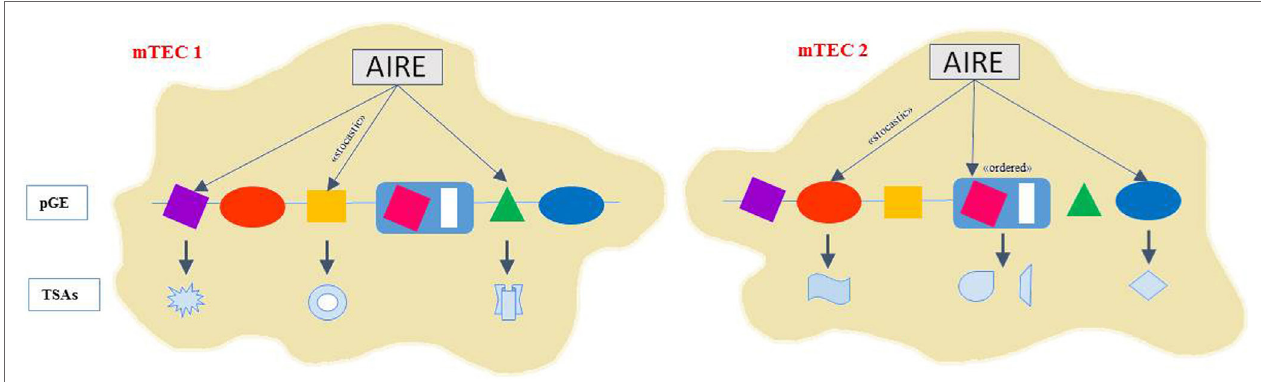
FiGURe 1 | AiRe controls gene expression with ordered stochasticity . AIRE seems to regulate pGE in mTECs in an apparently stochastic manner. Thus, single mTECs would express TRAs of mixed tissue origin rather than emulating cell line age-affiliated patterns displaying the highest degree and diversity of pGE. Indeed, different sets of TSAs are expressed in mTECs but whether a particular AIRE-regulated TSA is expressed in a given mTEC seems to be highly probabilistic. The “ordered” TSA expression refers to the increased likelihood that a particular set of TSA genes will be coexpressed in an individual mTEC. Coexpressed gene loci tend to colocalize to the same nuclear subdomain and TSA subsets align along progressive differentiation stages within the mature mTEC subset.